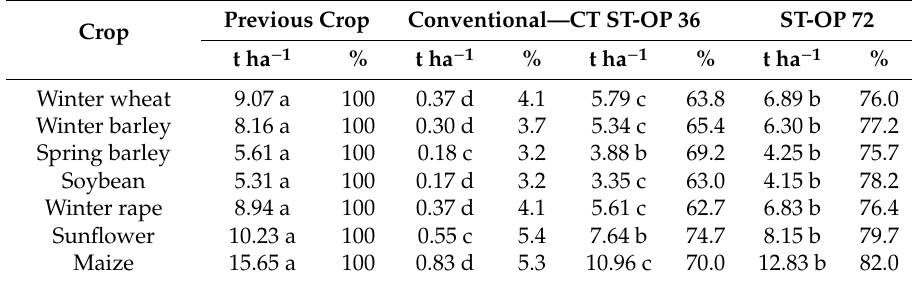
Table 2. Plant residues mass on the soil surface after the harvest previous crop (PC) and after various methods of soil tillage and the sowing. (conventional, CT, strip-till one-pass 36 cm, ST-OP 36; strip-till one-pass 72 cm, ST-OP 72). Previous Crop Conventional—CT ST-OP Crop